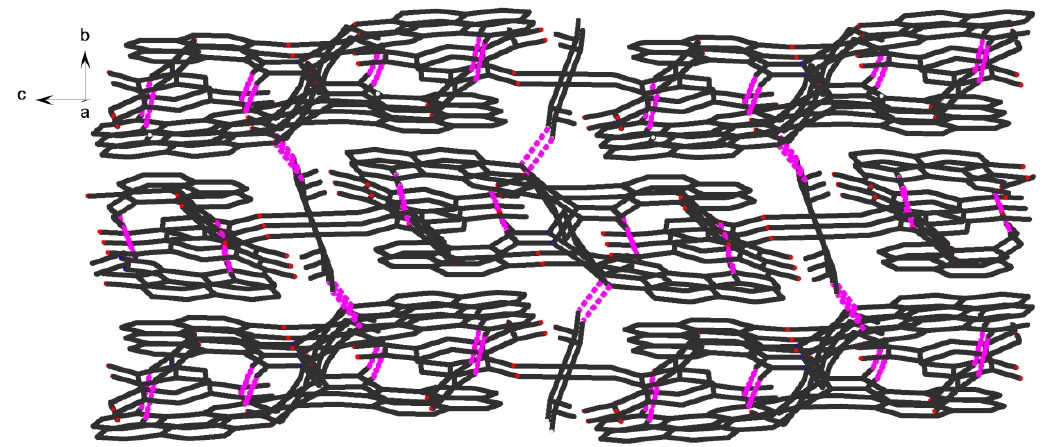
Figure 8. Part of 3D supramolecular network structure in 1 .